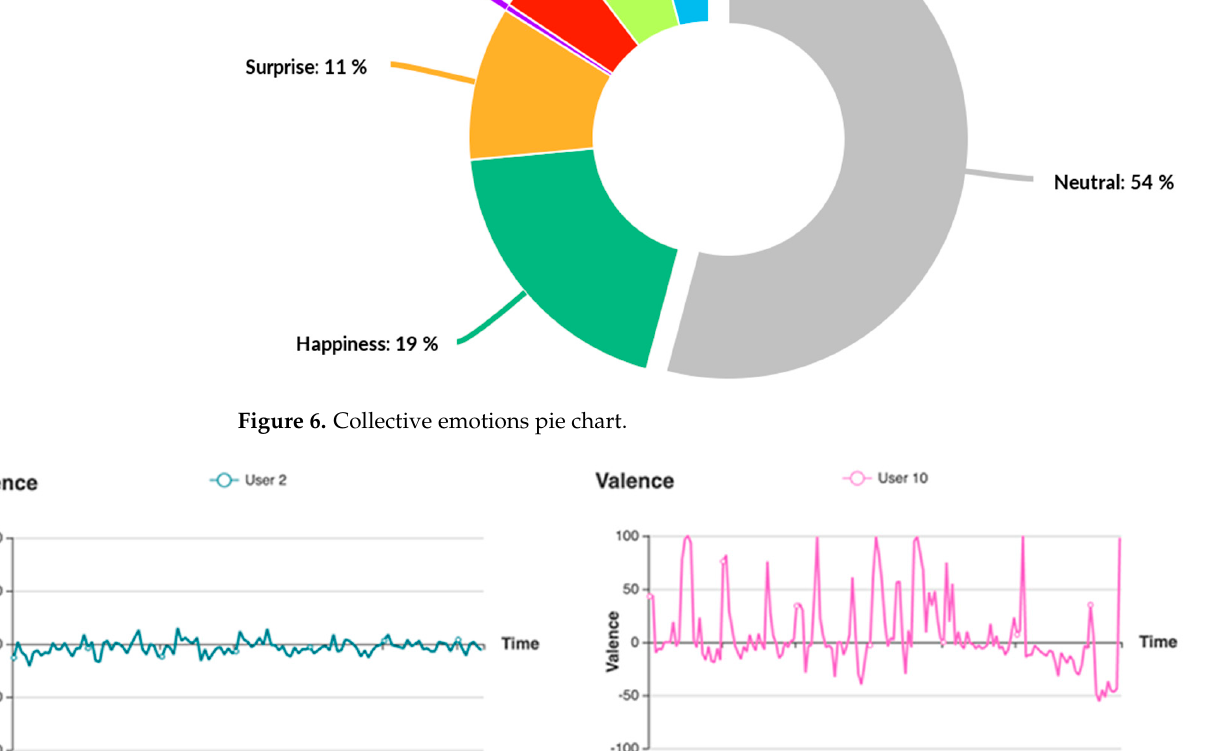
Figure 7. Valence graphs by user.